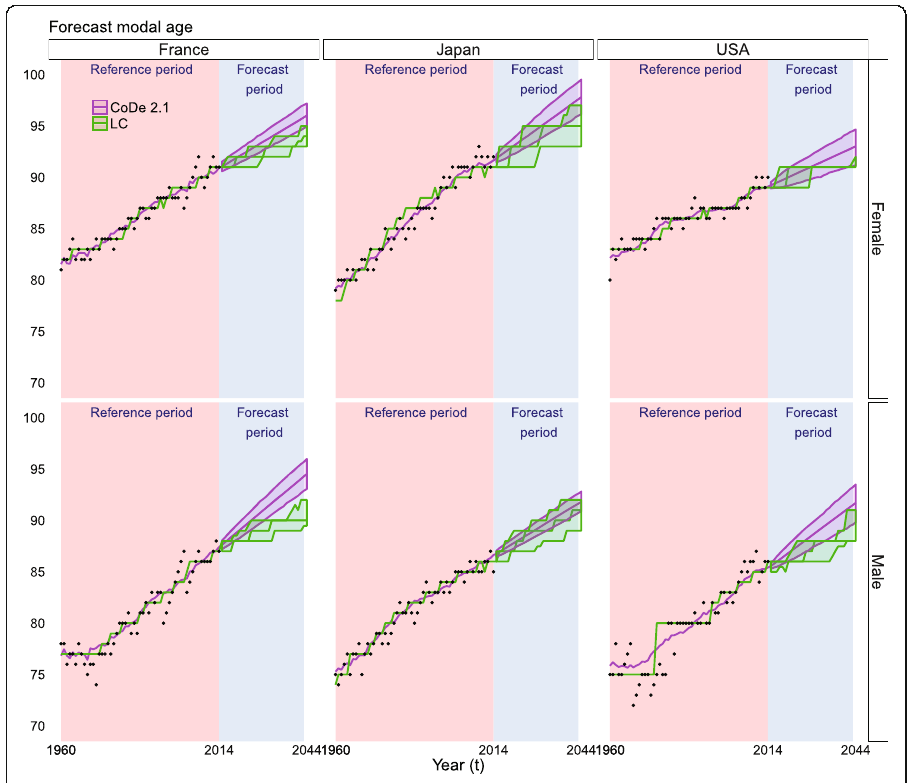
Fig. 12 Estimation and out-of-sample projections of the modal age using the CoDe 2.1 model and the LC model. The reference period is 1960 – 2014 (pink); the projection period is 2015 – 2044